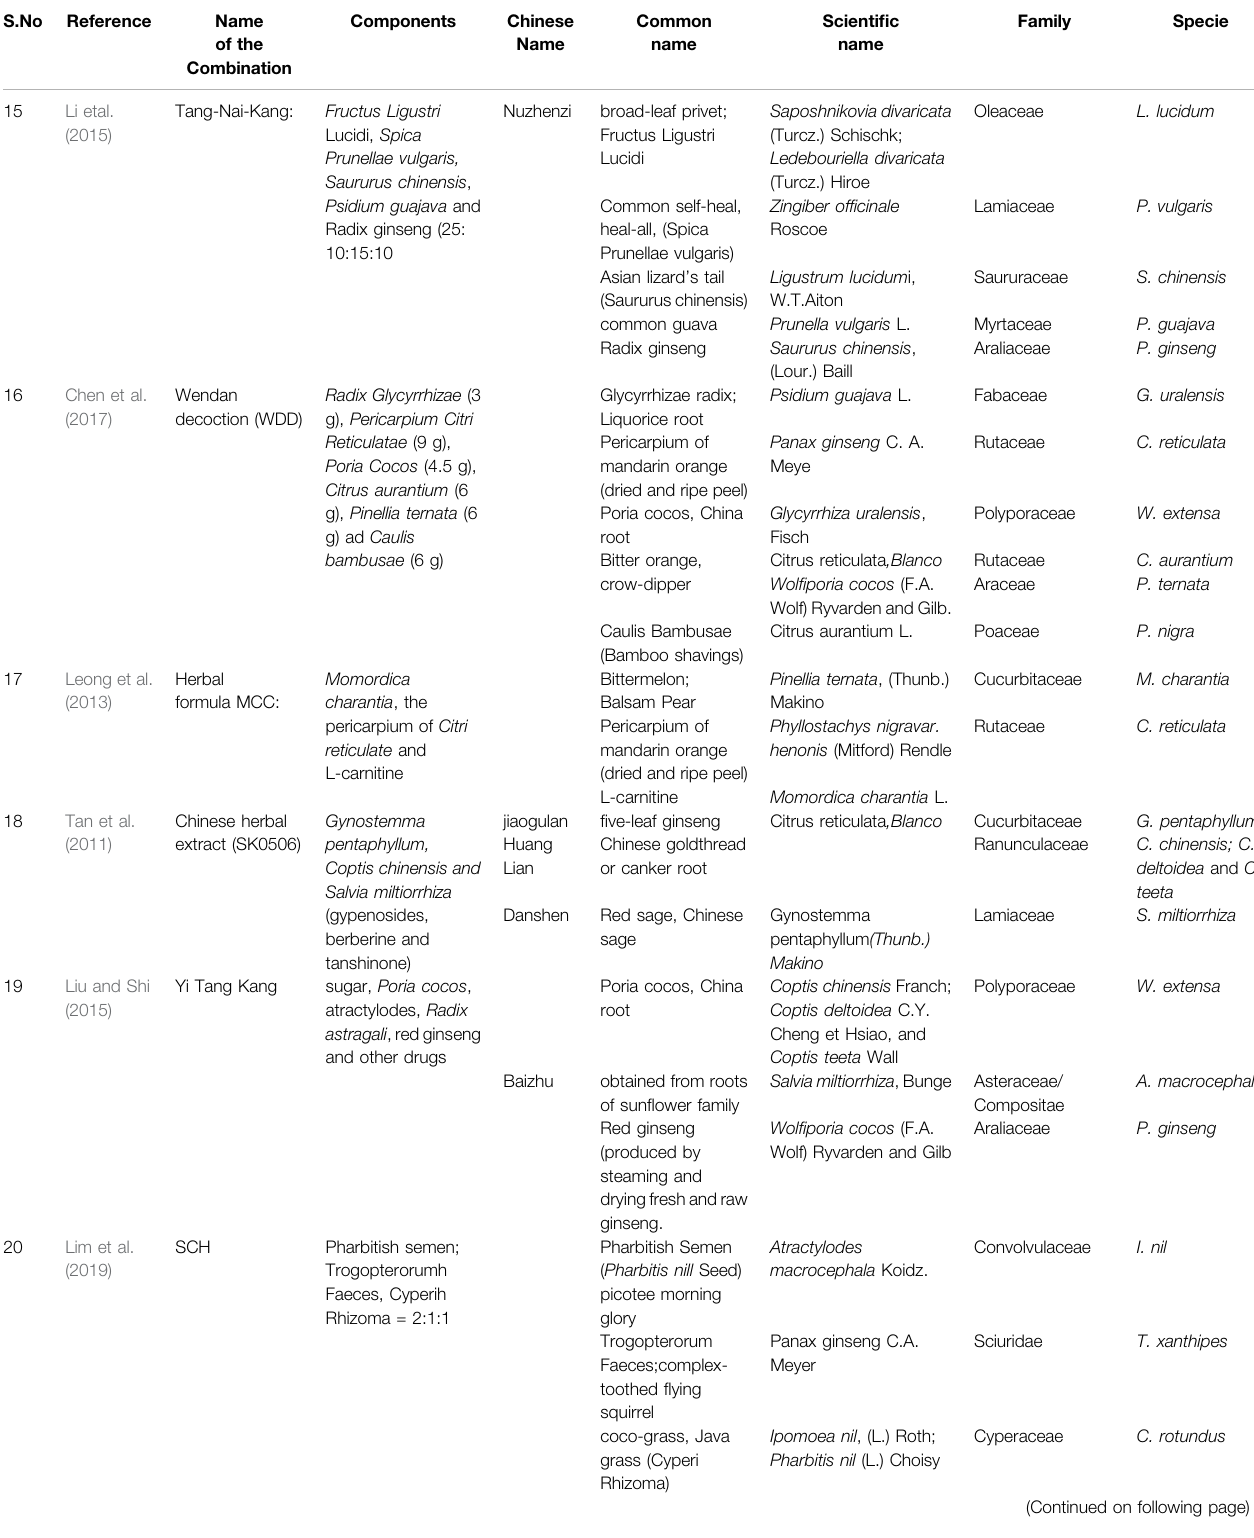
TABLE 1 | ( Continued ) Taxonomic classi fi cation of all the polyherbal combinations reviewed in animal